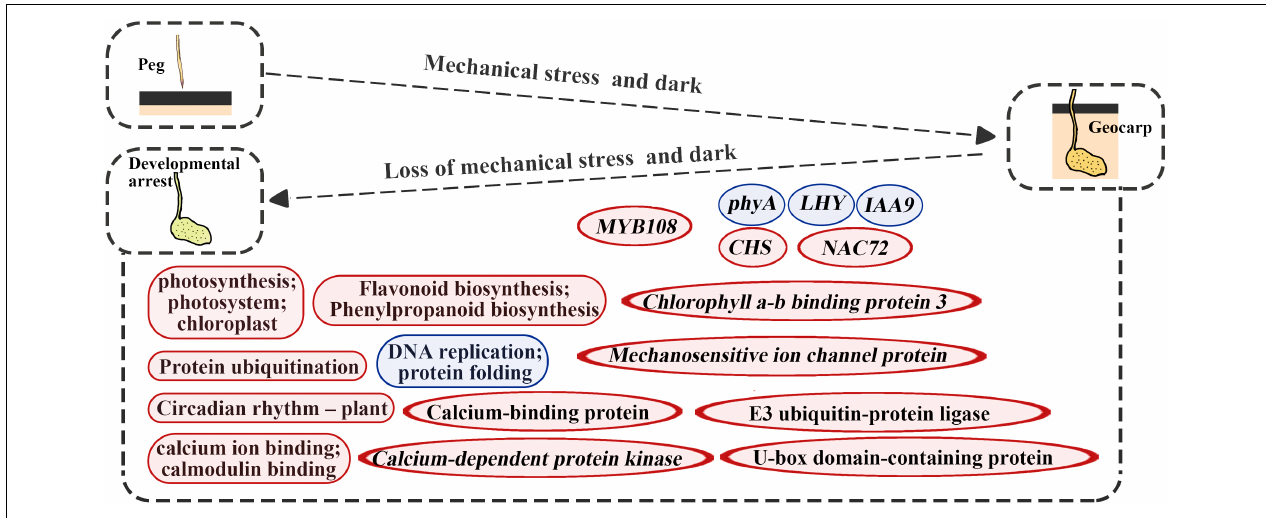
FIGURE 8 | Diagrams summarize changes in key molecular levels of developmental arrest caused by the absence of dark and mechanical stress. Round rectangles represent the GO term or KEGG pathways and the ellipse represents the gene; red represents upregulation and blue represents downregulation.